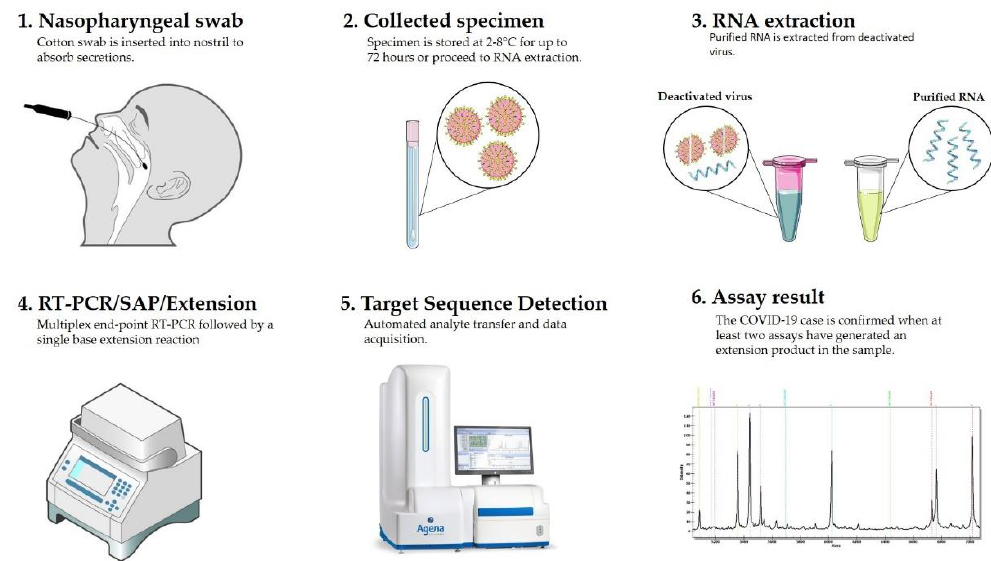
Figure 3. Workflow of COVID-19 diagnostic test through mass spectrometry method.